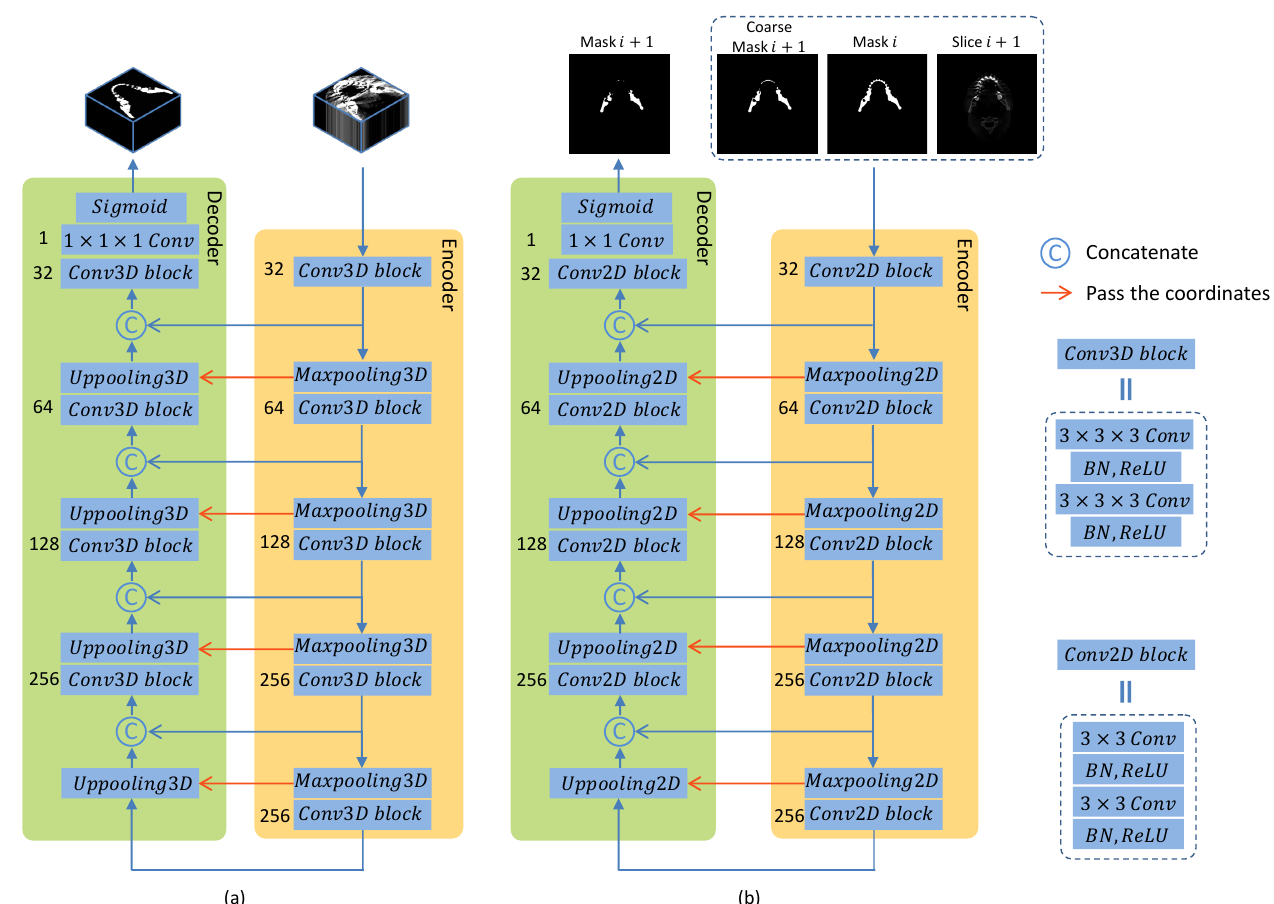
Figure 3. The detailed architecture setting of the proposed method consists of a 3D CNN ( a ) and a 2D recurrent segmentation network ( b